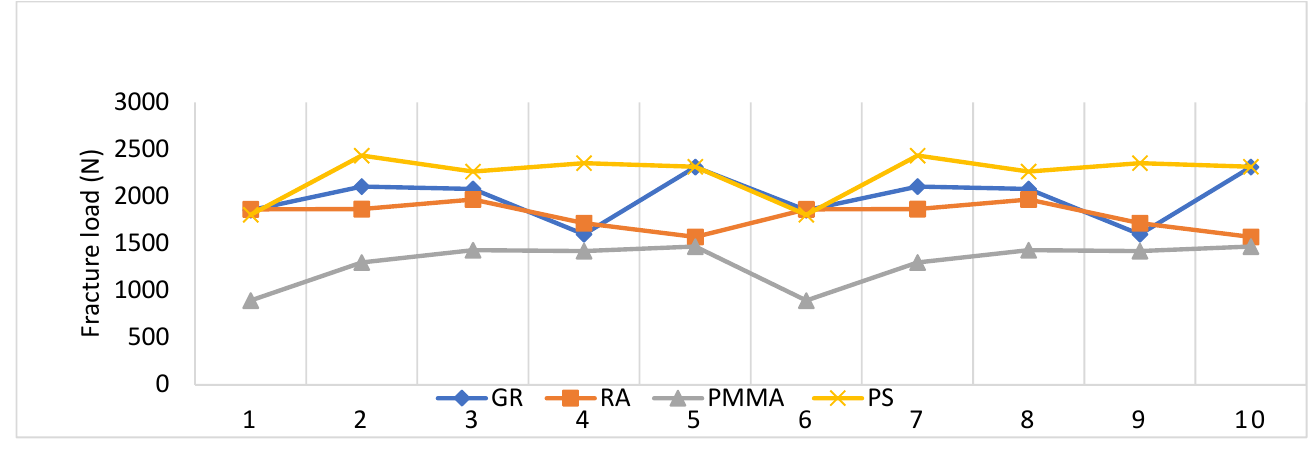
Figure 2. Comparison of fracture strength of GRA, RA, PMMA and PS materials.